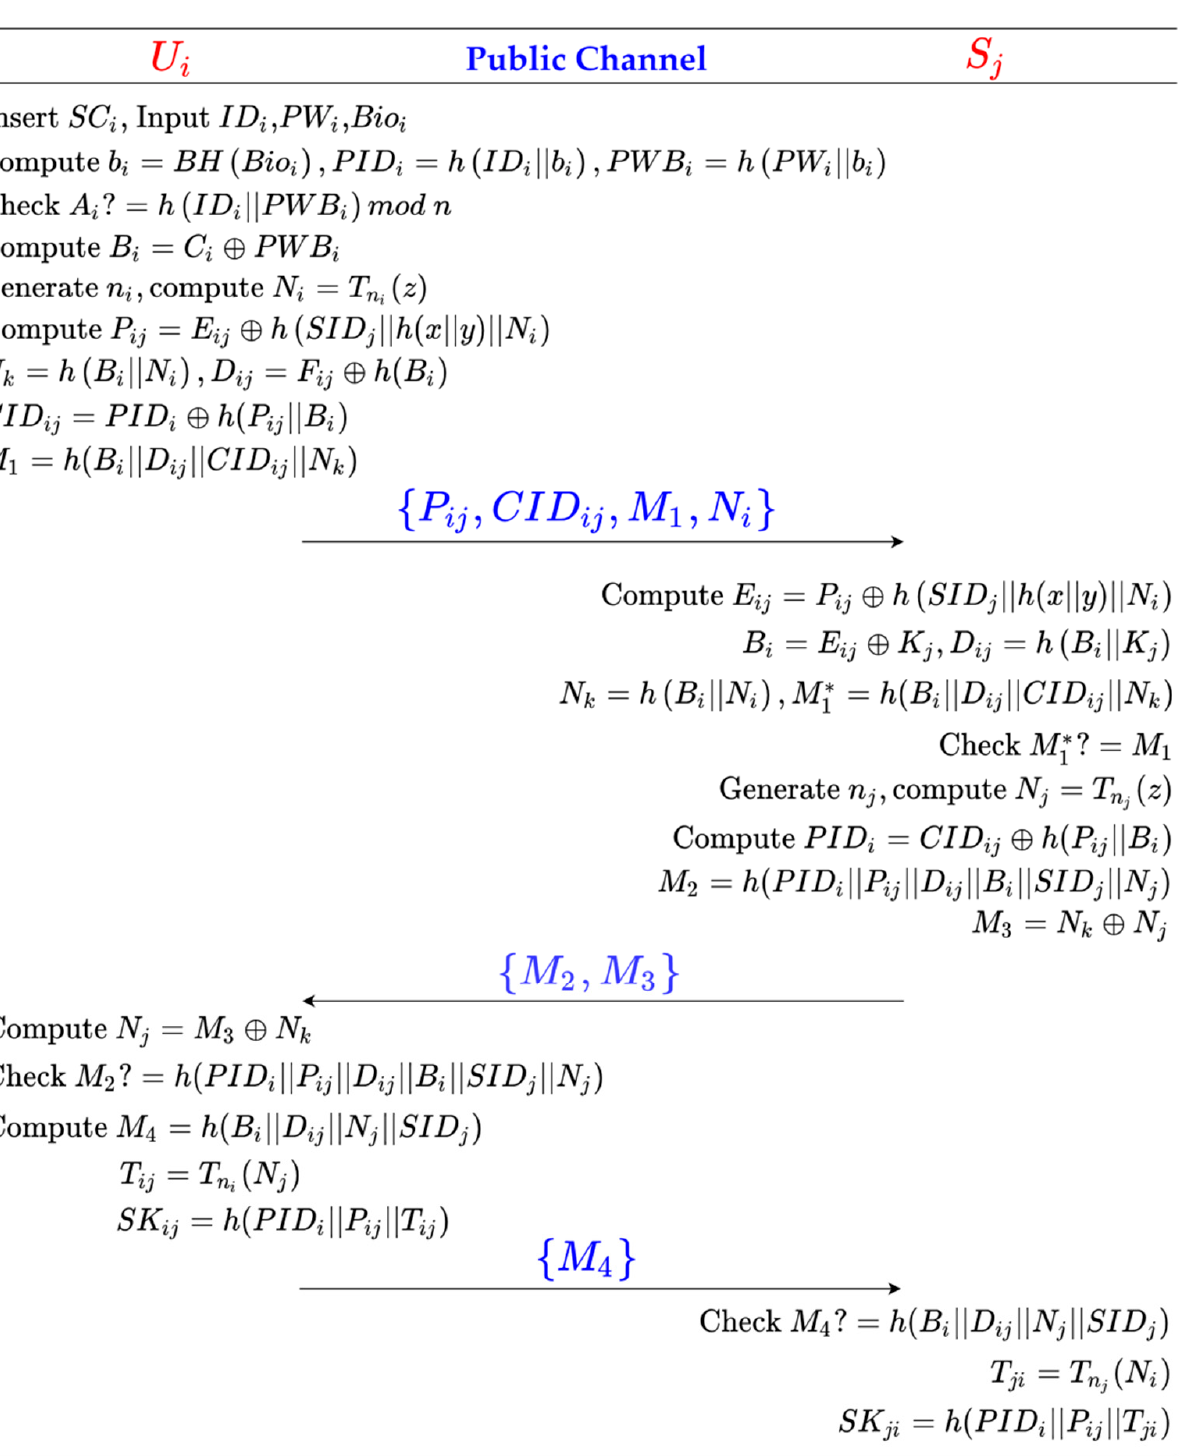
Figure 5. Login and authentication phase of the proposed scheme.